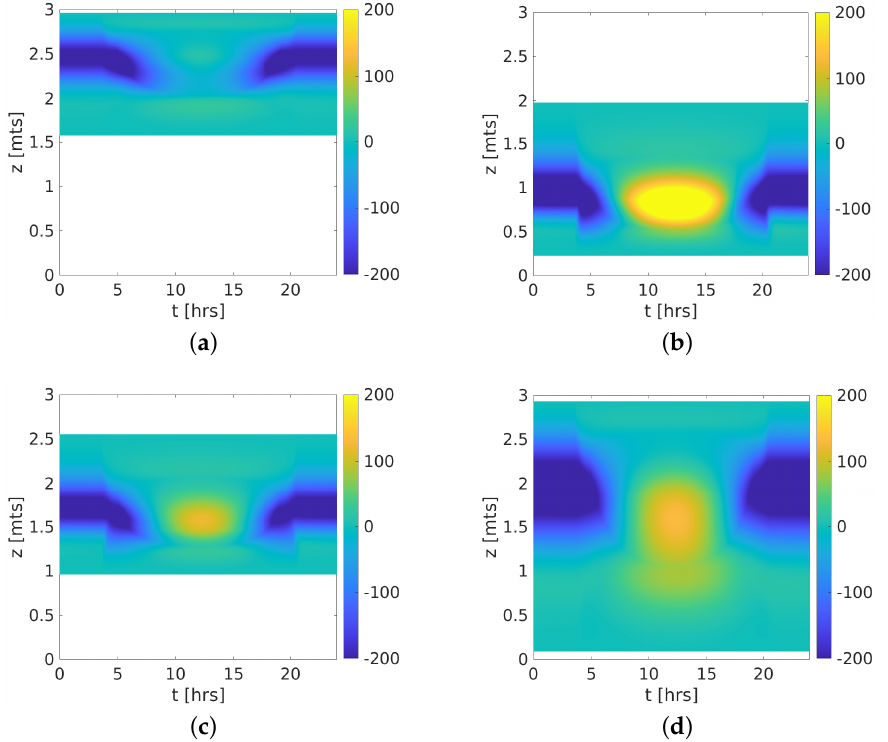
Figure 2. Energy change ∆ E at 24 h for all canopy shapes. ( a ) Case 1; ( b ) Case 2; ( c ) Case 3; ( d ) Case